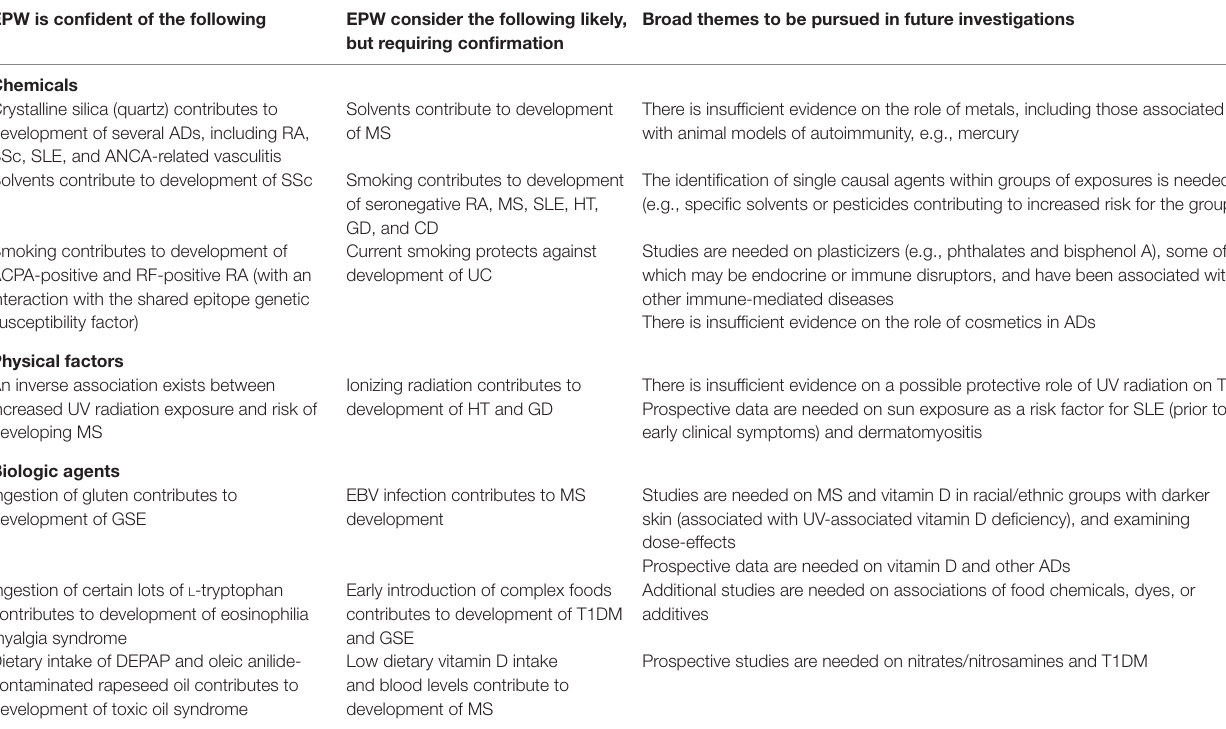
TABLe 1 | Findings on human studies on the role of environmental factors and development of autoimmune